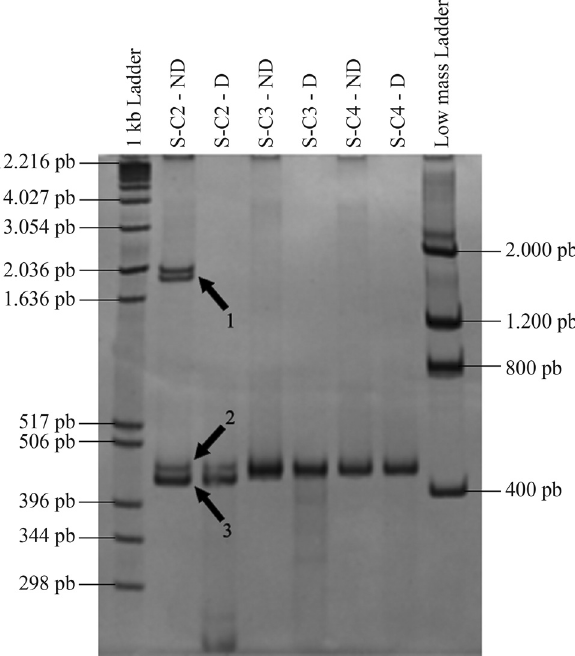
Figure 5 - T7-endonuclease assay to confirm the existence of hetero- duplexes. Five microliters of PCR product from three TA-positive colo- nies (S-C2, S-C3 and S-C4, the same as used in Figure 4) were hybridized with an equal amount of a corresponding wild-type PCR product. The ma- terial was then digested with 5 IU of T7-endonuclease for 30 min and run on a 10% acrylamide gel. For each digestion (D) an equivalent amount of non-digested (ND) material was run as a control. A 1 kB ladder and a low mass ladder (LifeTechnology) (1 (cid:2) g each) were run in each gel. Arrow 1 - two heteroduplex bands, arrow 2 - band containing homoduplex wild- type, double-stranded DNA, and arrow 3 - band containing TALEN- edited (deleted), homoduplex double-stranded